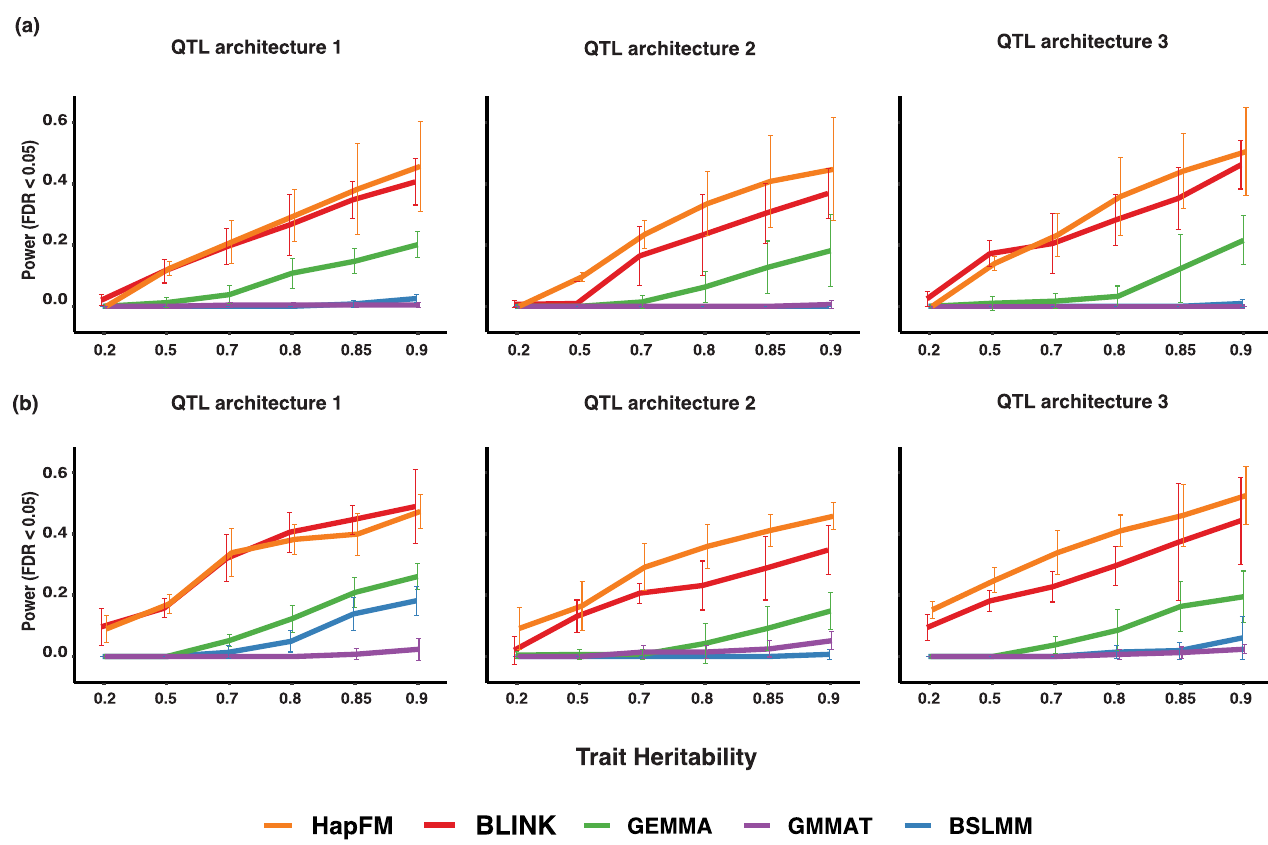
Fig 3. Mapping power comparisons of different GWAS algorithms in the high polygenicity simulations using real plant genotype datasets. The x-axis indicates the trait heritability. (a) Mapping power comparisons (FDR < 0.05) of different GWAS algorithms from the Arabidopsis dataset containing 1135 individuals. (b) Mapping power comparisons (FDR < 0.05) of different GWAS algorithms from the soybean dataset containing 2898 individuals.